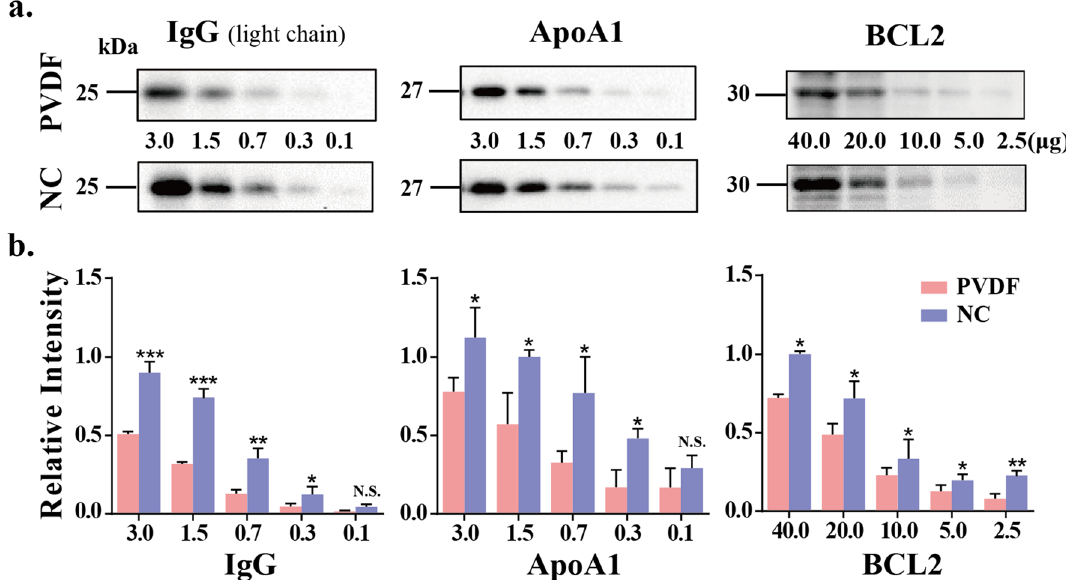
Figure 1. Comparison of the binding ability of PVDF membrane and NC membrane to low molecular weight proteins. ( a ) Indicated numerals are amounts (3.0, 1.5, 0.8, 0.4, 0.2 and 0.1 μg) of the pooled sera proteins subjected to 8% SDS-PAGE or cell proteins (40, 20, 10, 5 and 2.5 μg) subjected to 12% SDS-PAGE. The electroblotted membranes are PVDF membrane (top) and NC membrane (bottom), respectively. The membranes were incubated with anti-IgG, anti-ApoAl and anti-BCL2 antibodies. ( b ) Staining intensities were statistically analyzed (n = 3 individual experiments). Pink bar, PVDF membrane; Blue bar, NC membrane. Band intensities were analyzed and compared using Image Lab software (Bio-Rad Laboratories) and GraphPad Prism version 6. *Significantly different p < 0.05, ** p < 0.01, *** p < 0.001. N.S., not significant. All values are means ± S.E. (error